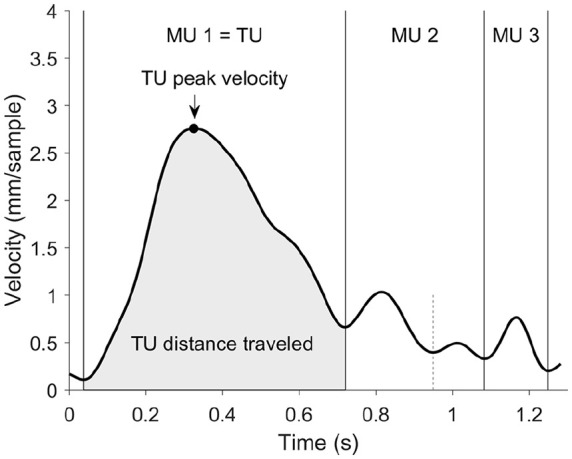
Example velocity profile from one of the participating infants. A reach is divided into movement units (MUs) from their local minima. The transport unit (TU) represents the largest MU toward the target. The main kinematic variables were the TU peak velocity (as shown by arrow) and TU distance traveled (gray area). The short dashed line indicates a local minimum where two MUs were merged into one.